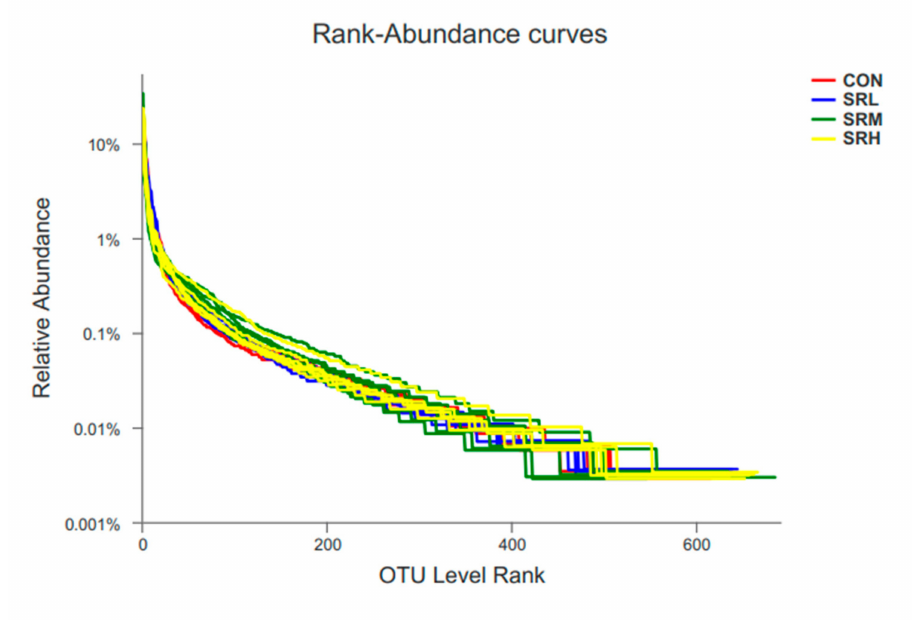
Figure 2. Operational taxonomic units (out) rank–abundance